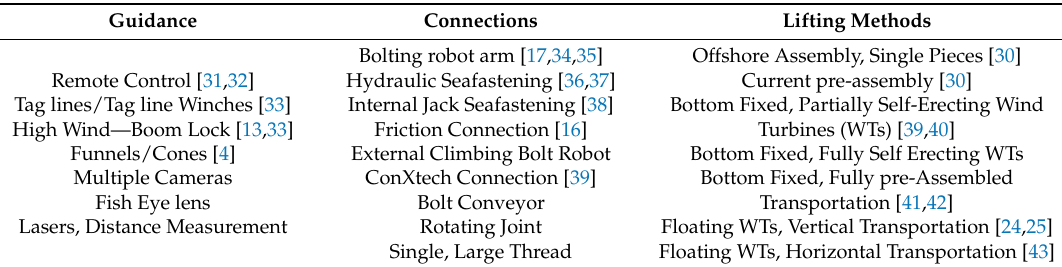
Table 3. List of options compared in initial stage